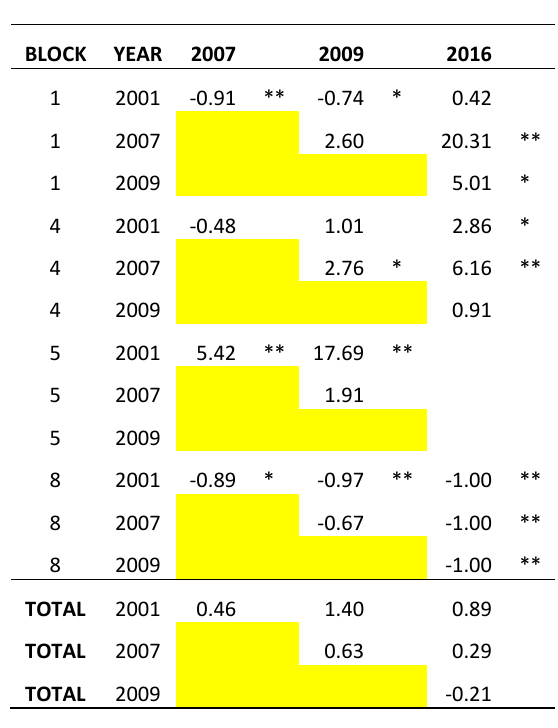
Table 5. Comparison of perception bias corrected abundance estimates of white-beaked dolphins for selected strata and the entire survey area. Estimates from 2001 are from Pike et al. (2009). Only strata where significant ( P <0.05) changes to or from non-zero values occurred are shown. Cells list proportional change from first year to second. Blank cells not sampled in one of years. Proportion of -1 indicates